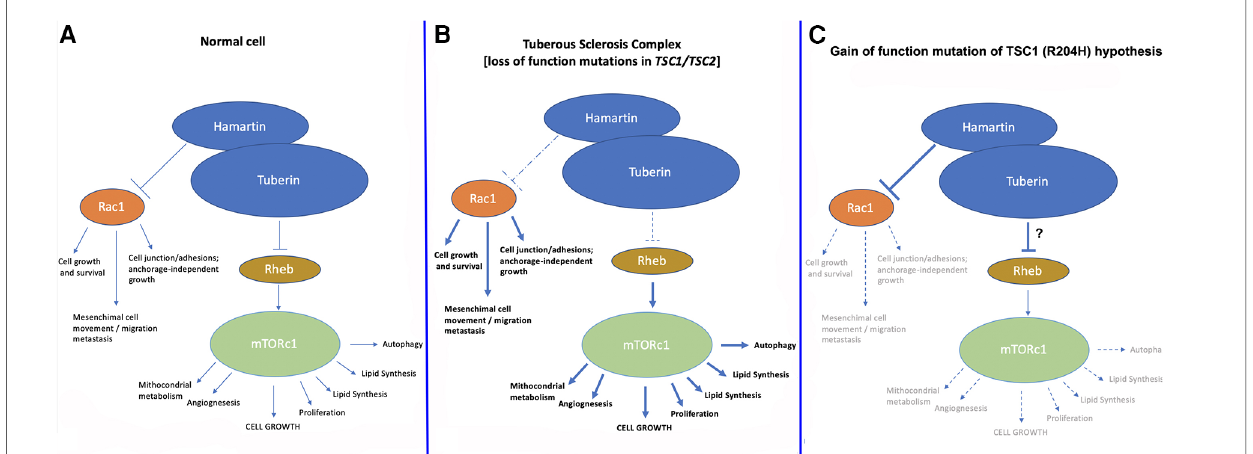
FIGURE 2 Normal pathway of hamartin/tuberin inhibition of mTORC1 and Rac1 pathways ( A ) compared to ( B ) the current TSC model and ( C ) the “ gain-of-function of hamartin ” hypothesis postulated in the case described herein. We hypothesize that in the present case, increased inhibition of mTORC1 and/or Rac1 led to the phenotype of reduced cerebral growth; another explanation could be found in the increased interaction between hamartin and tuberin leading to increased inhibition of mTORC1. In both cases, a substantial reduction in the growth and replication of neuronal cells in a very early phase during embryonic/fetal life likely led to the clinical manifestations recorded in our patient, which in turn may represent an “ inverse/reverse TSC1 phenotype ”